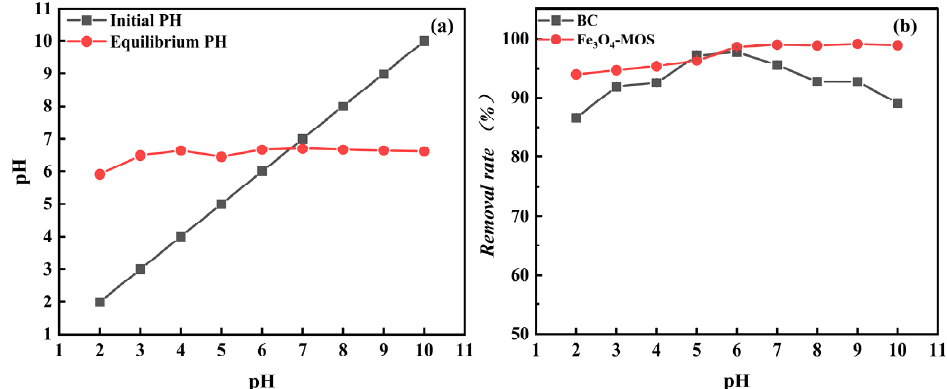
Figure 6. pH pzc of Fe 3 O 4 -MOS ( a ) and the effect of pH on the adsorption of MB by BC and Fe 3 O 4 -MOS ( b ).